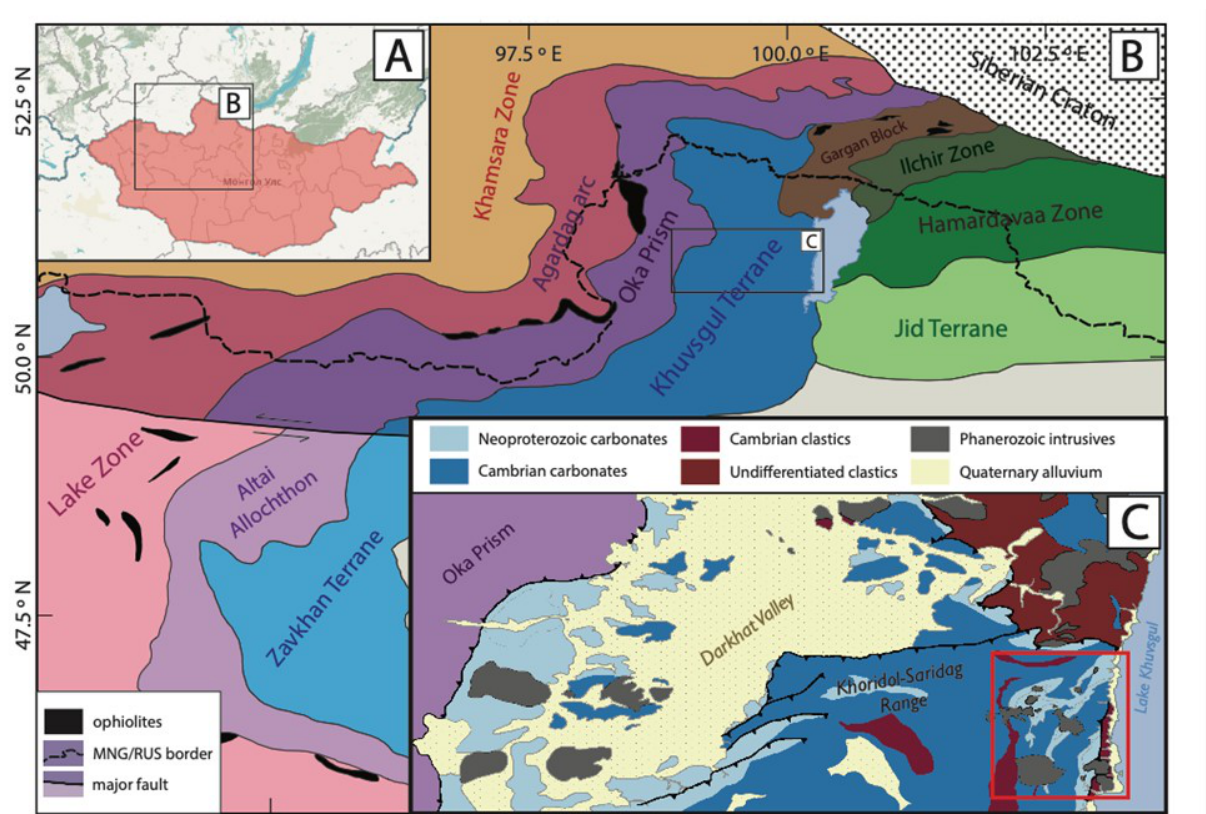
Fig. 1. Location and geologic context of northern Mongolia. A: Geopolitical map of northern Mongolia. B: Tectonic map of the northern Mongolian portion of the Central Asian Orogenic Belt, modified from Bold et al. (2016b, 2019) and Kuzmichev (2015). C: Generalized geologic map of the Khoridol-Saridag Range and Darkhat Valley. A detailed geologic map of the area outlined in red is shown in Fig.